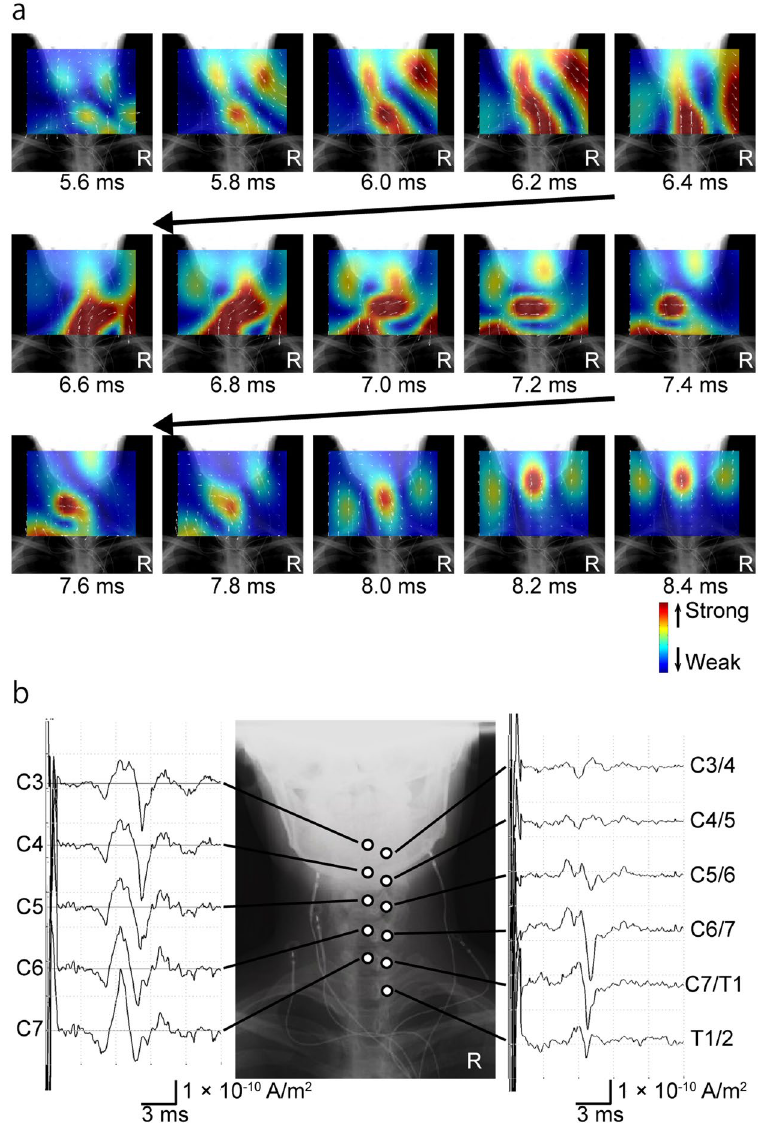
Figure 6. Reconstructed currents after stimulation of the right median nerve at the elbow. ( a ) Reconstructed current map. The currents flowed into the spinal canal from the right side and propagated cranially 5.6–6.4 ms post-stimulus. Rotated currents were observed 6.6–7.6 ms post-stimulus. Trailing currents propagated cranially 7.8–8.4 ms post-stimulus. ( b ) Reconstructed currents at the midline of the cervical spinal canal (C3 to C7) and at the adjacent intervertebral foramina (C3/4 to Th1/2). The first peak of the reconstructed currents at the midline of the cervical spinal canal did not propagate, but subsequent currents did (left graphs). Currents flowing into the intervertebral foramina were larger at C5/6 to C7/Th1 (right